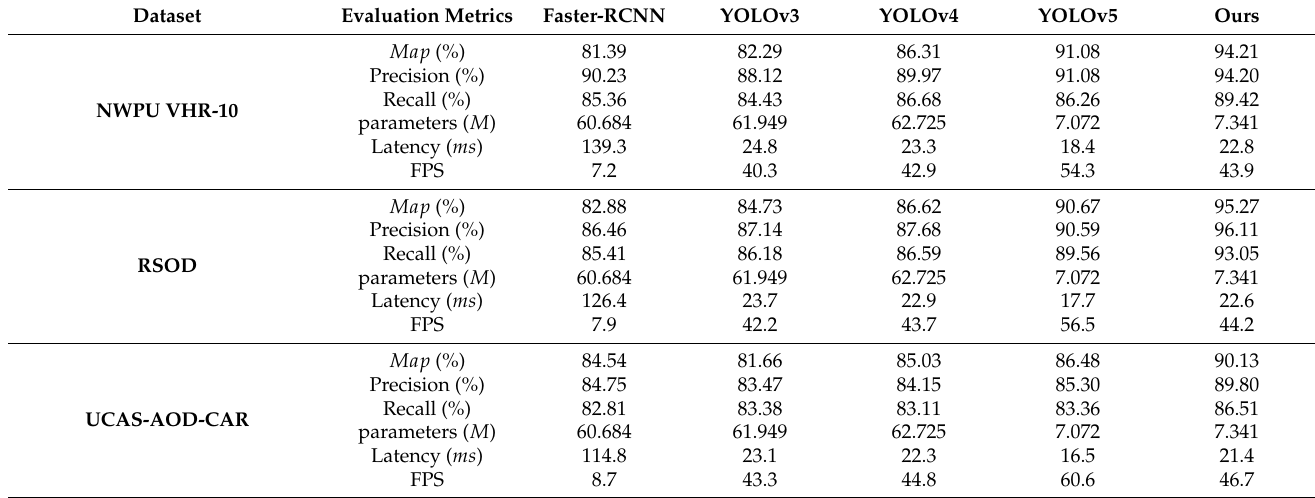
Table 12. Comparison of the KCFS-YOLOv5 with the common algorithms on all three datasets.